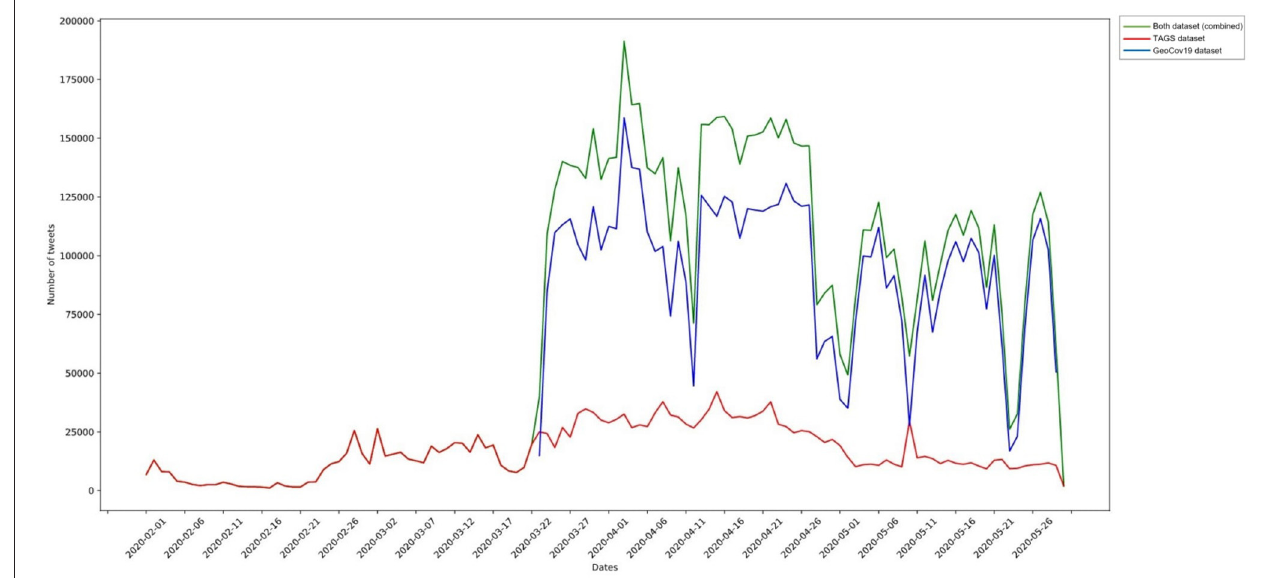
FIGURE 2 | Time series of distribution of tweets in TAGS, GeoCov19, and combined